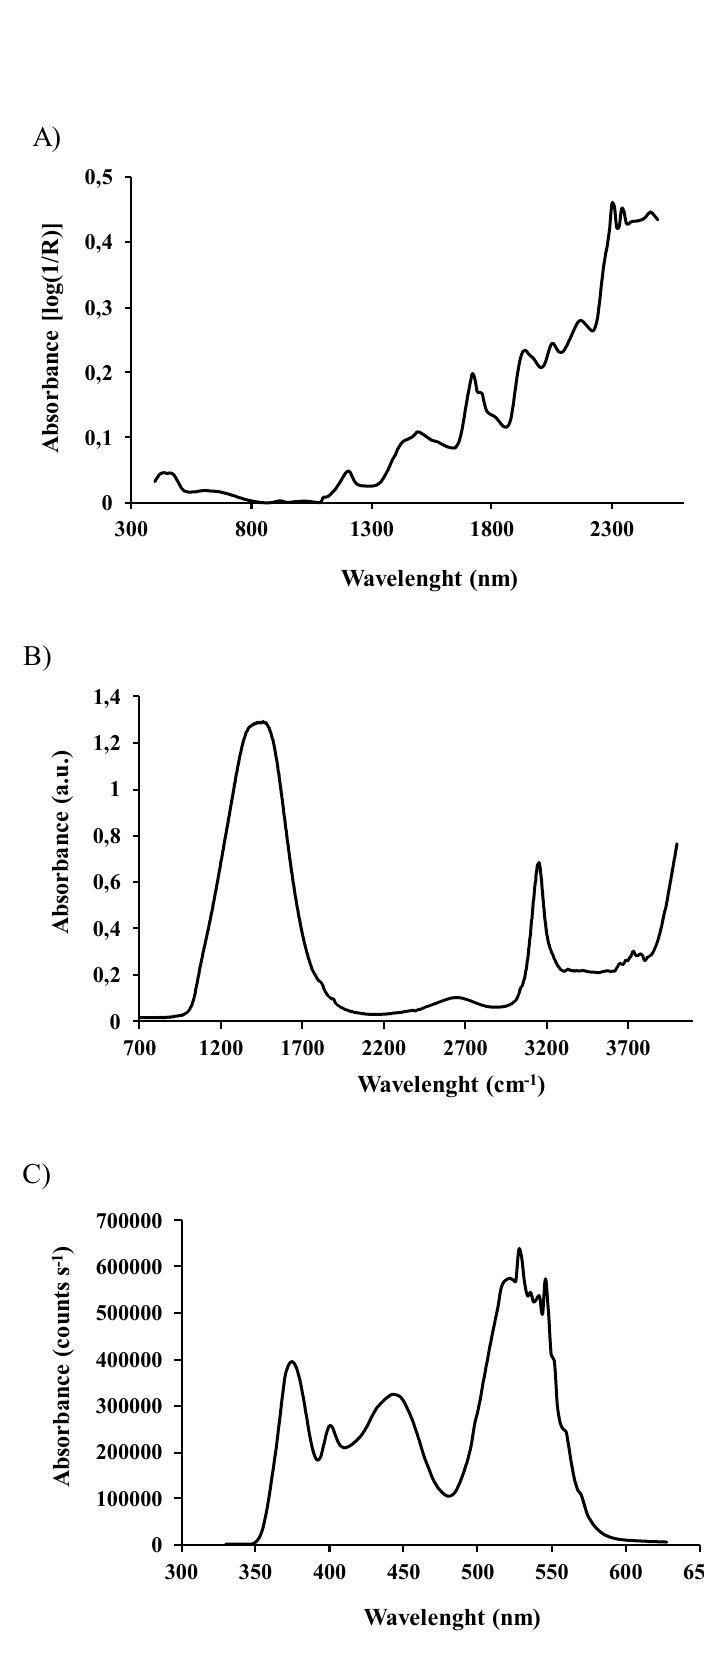
Figure A1. Illustration of each average raw spectrum obtained by near-infrared ( A ), mid-infrared using attenuated total reflectance cell ( B ), and synchronous fluorescence method ( C ). (R: reflectance).